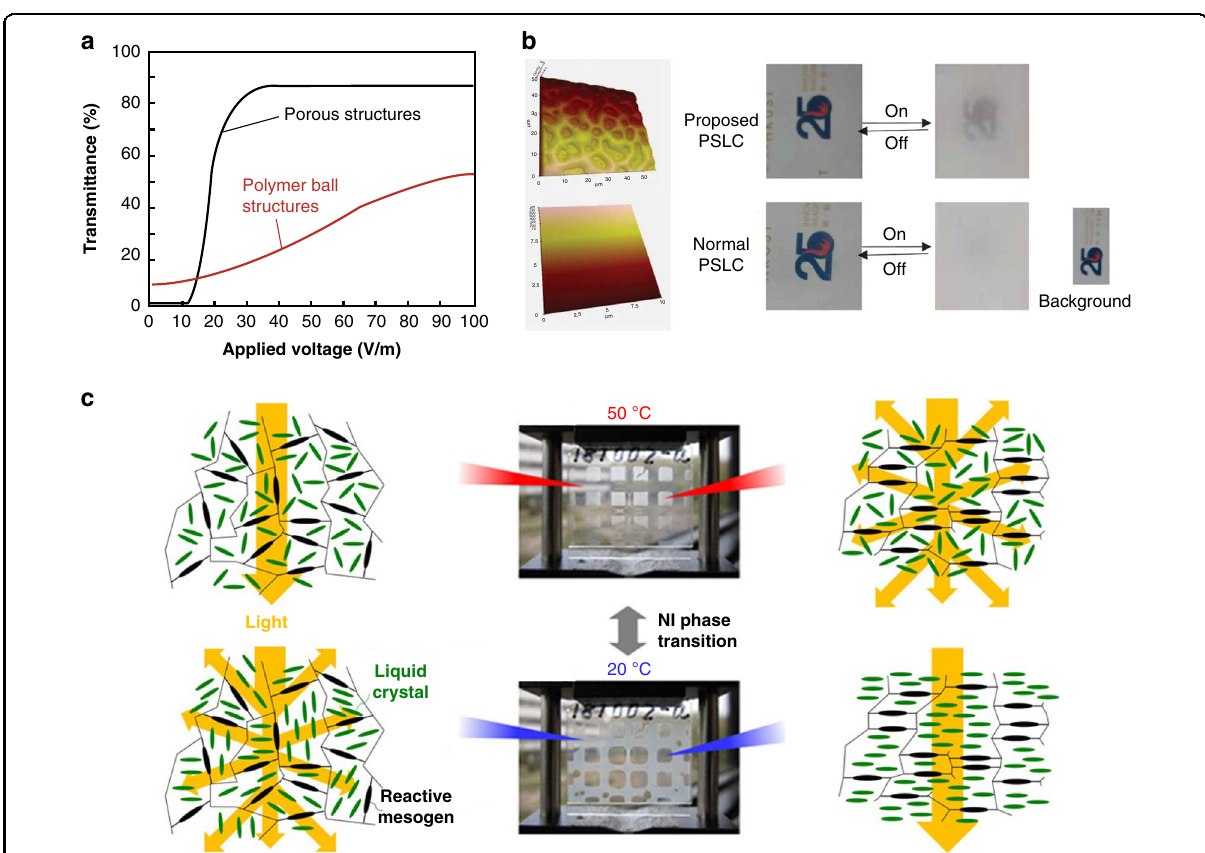
Fig. 10 Switchable optical devices based on polymer-liquid crystal materials. a The regulation of electro-optical properties by the morphologies of polymer networks in PDLCs. b Effects of power on haze states PSLC. The results in the upper and lower rows were from inhomogeneous and smooth fi lms with vertical alignment, respectively. Reproduced with permission from ref. 142 . Copyright 2019, Taylor & Francis Group. c Demonstration of the optical clarity of a grid-patterned sample with normal- and reverse-mode thermoresponsive switching ability. Reproduced with permission from ref. 144 . Copyright 2019, American Chemical